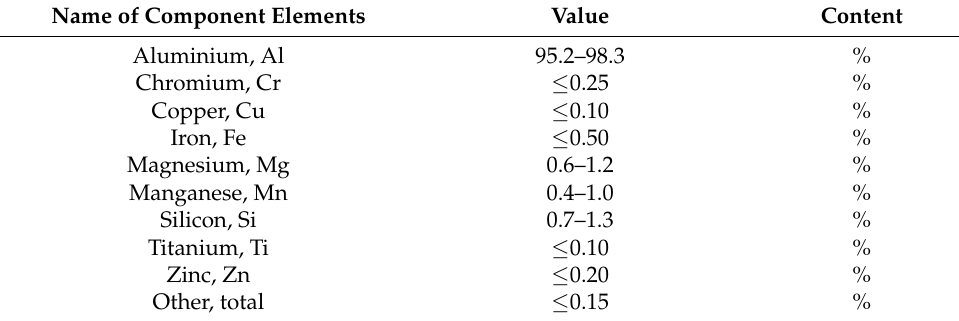
Table 1. Chemical composition of the material EN AW-6082-T6 according to EN-573-3:2019 [50]. Name of Component